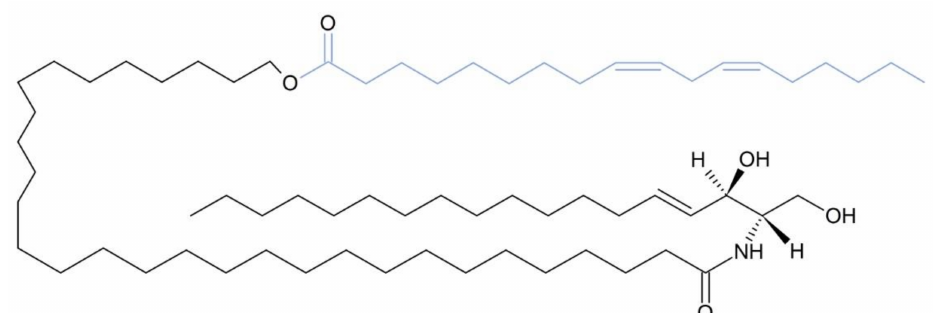
Figure 6. Molecular structure of ω - O -acylceramide. The α / β hydrolase domain containing protein 5 is involved in the esterification of ω -hydroxyceramide with linoleic acid (fatty acid chain colored in purple), producing ω - O -acylceramide. The molecular similarities between ω - O -acylceramide and triacylglycerol estolide (compared with Figure 4) are worth noting, as both molecules contain a fatty acid esterified to a hydroxy fatty